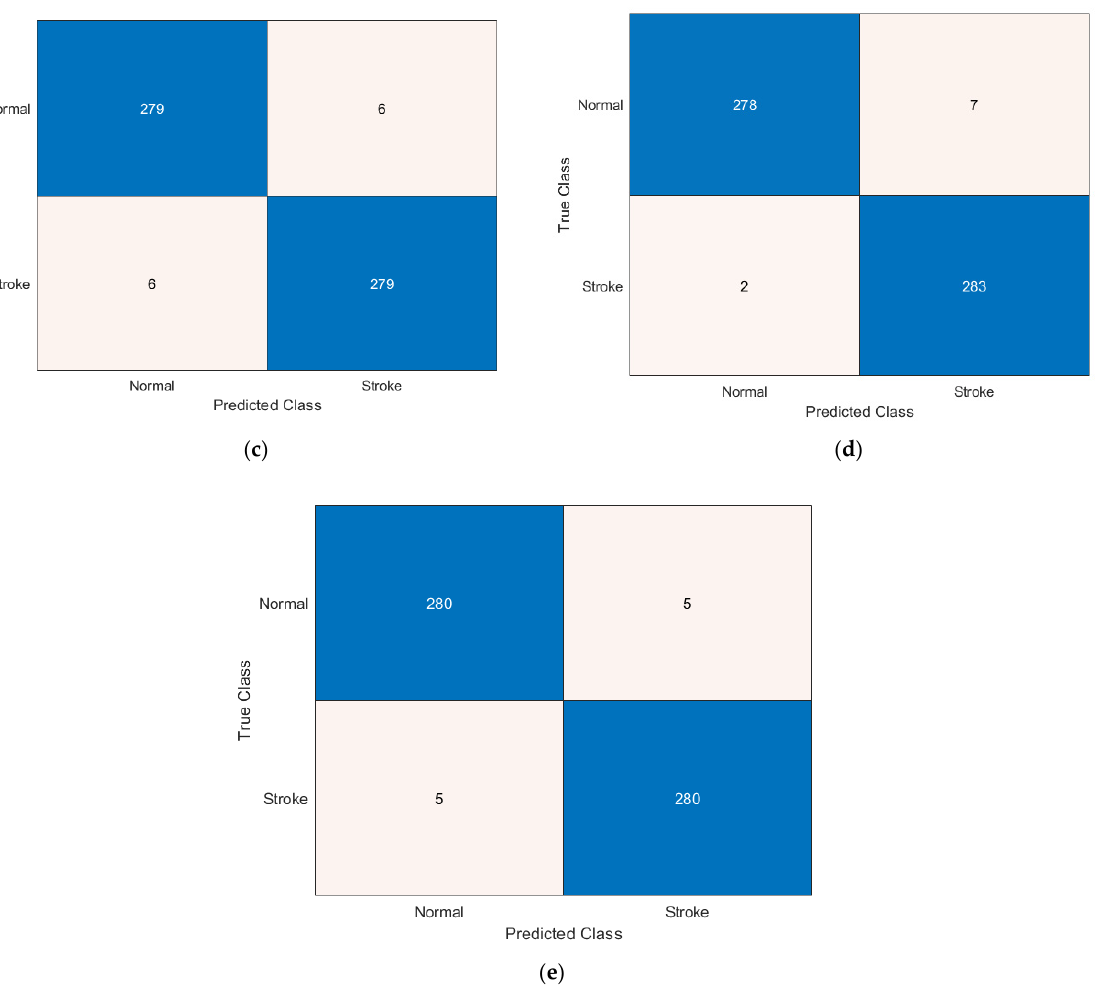
Figure 3. Confusion Matrices of OzNet hybrid algorithms ( a ) OzNet-mRMR-DT. ( b ) OzNet-mRMR-